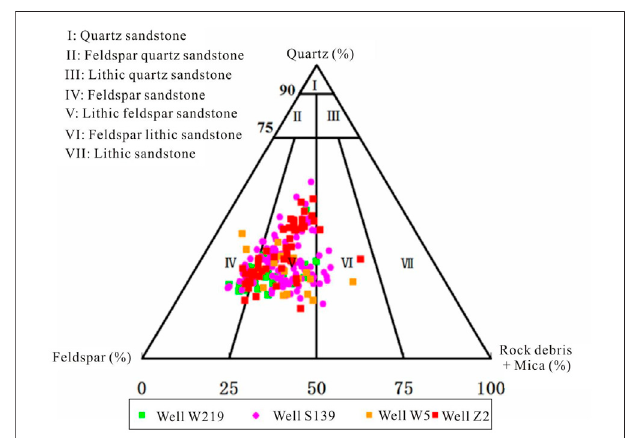
FIGURE2| Classi fi cationofsandstonelithology oftheChang6Member in the study